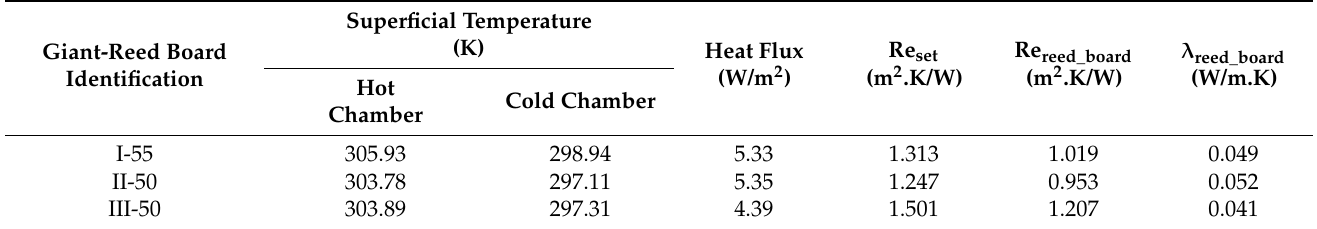
Table 5. Average values of the studied thermal parameters: giant-reed boards from Regions I, II and III.